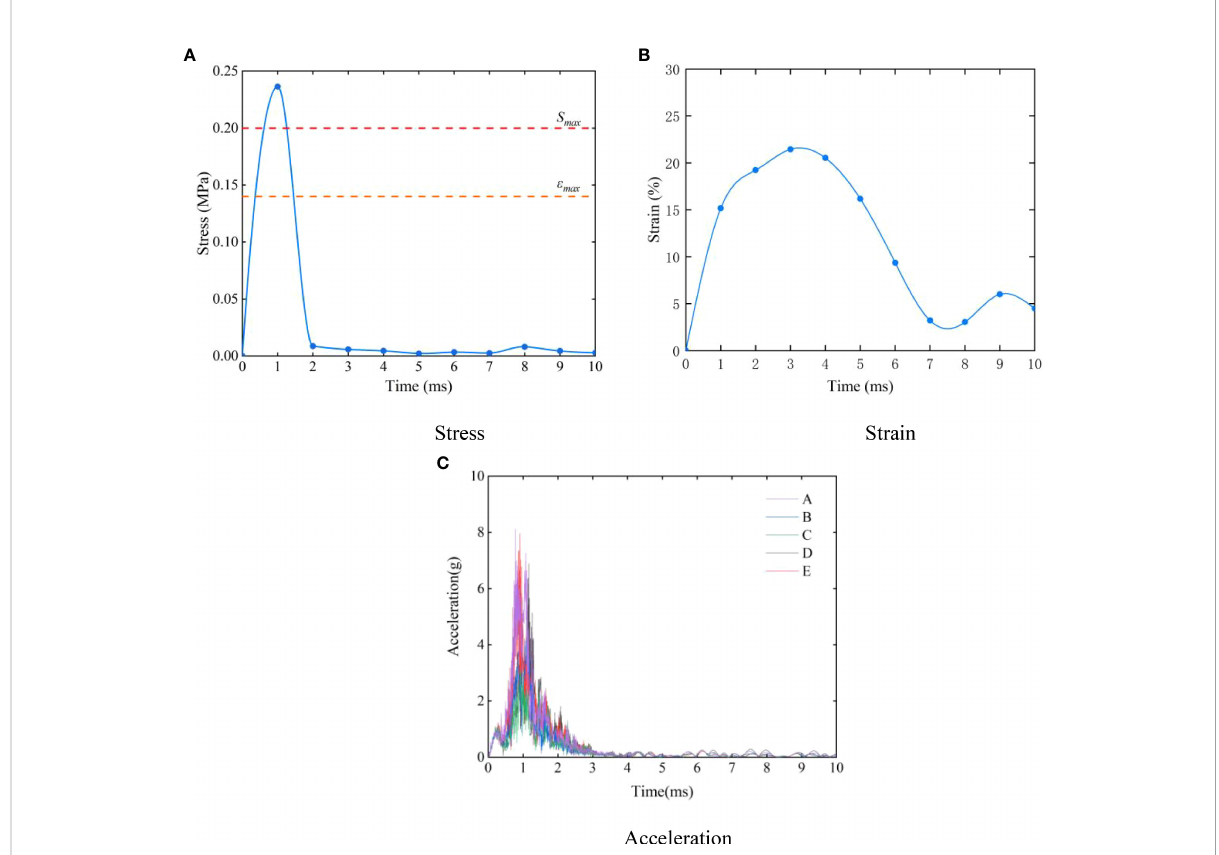
FIGURE 9 History curve of each response and time in collision process (A) stress; (B) strain; (C)